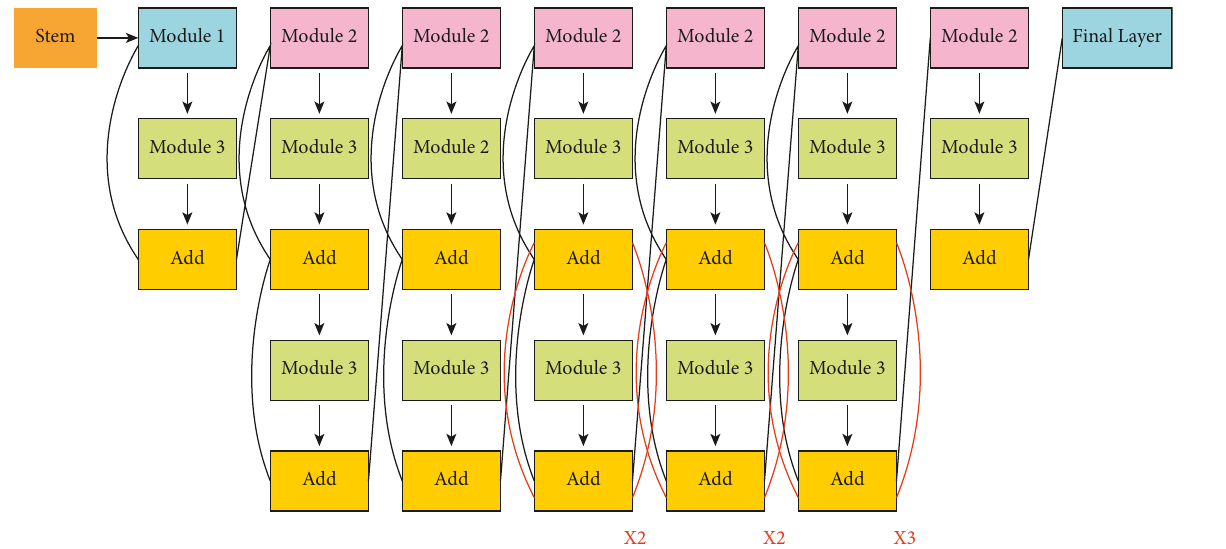
Figure 7: The model architecture of